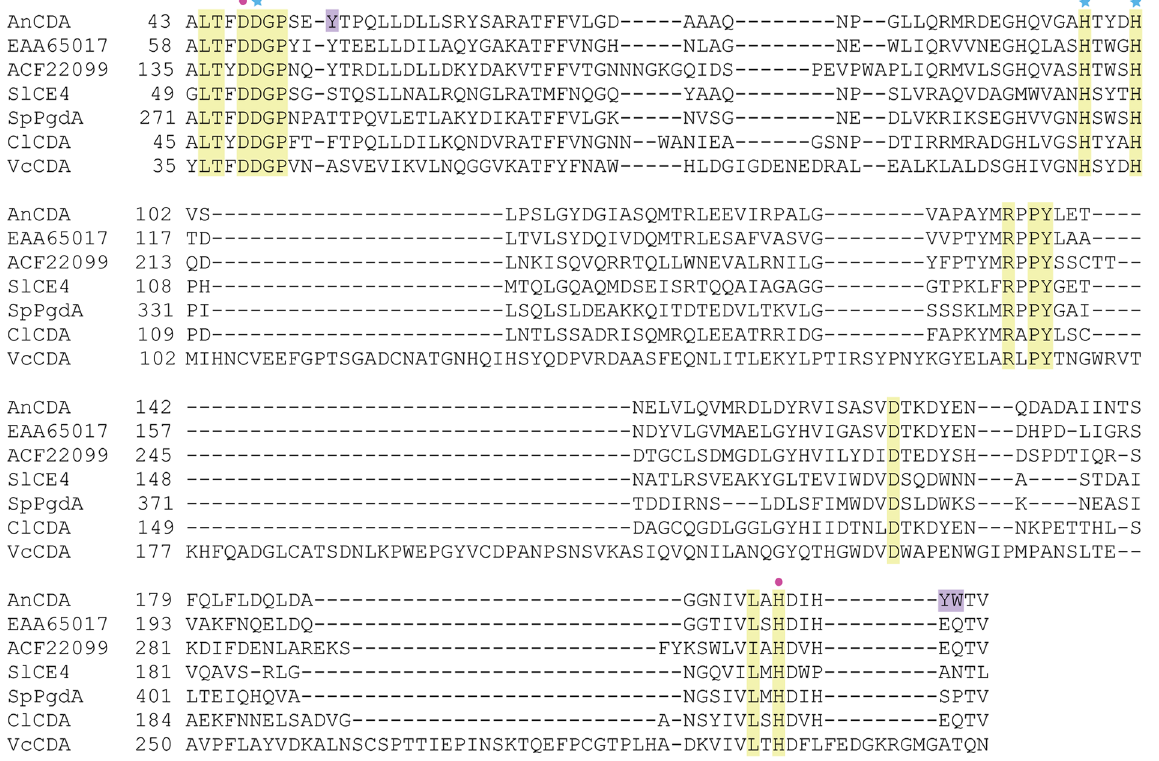
Figure 1. Structure-based multiple sequence alignment of the catalytic (NodB-like) domains of CE4 family enzymes. The alignment comprises four enzymes with known deacetylase activity and three putative chitin deacetylases from Aspergillus nidulans FGSC A4, An CDA (EAA66447, this study), EAA65017 and ACF22099. The other enzymes are: Sl CE4, acetyl xylan deacetylase from Streptomyces lividans , AAC06115.2 17 ; Sp PgdA, peptidoglycan deacetylase from Streptococcus pneumoniae , NP_358926 15 ; Cl CDA, CDA from Colletotrichum lindemuthianum , AAT68493 9 ; Vc CDA, CDA from Vibrio cholerae , AAF94439.1 18 . Fully conserved residues in the five sequence motifs that are important for activity (see text) 15 are shown with yellow background. The purple background indicates aromatic surface residues in An CDA that are discussed in the text. Blue asterisks indicate residues in the metal binding triad, while pink dots indicate the catalytic acid and base 15, 17 . The alignment was prepared with PyMod 2.0 (plugin in PyMol) 51 by doing a structure based sequence alignment of An CDA, Sl CE4, Sp PgdA, Cl CDA, and Vc CDA, before adding EAA65017 and ACF22099 to the